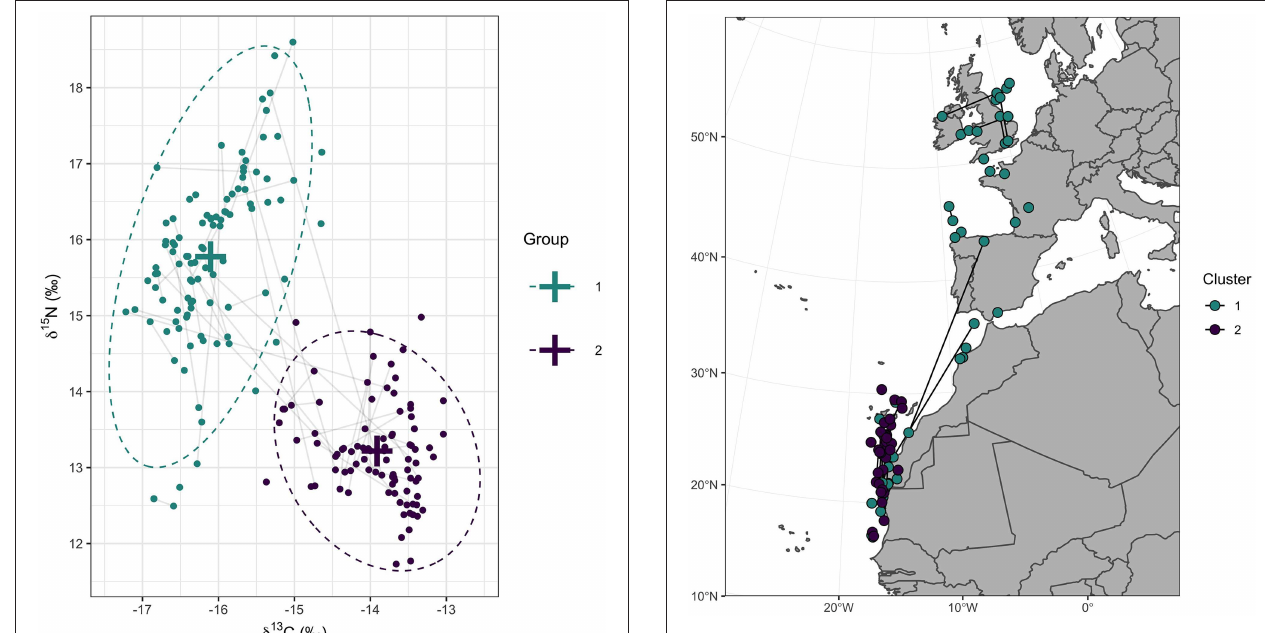
FIGURE 4 | Centroid December locations of 56 northern gannets colored by assignment to one of two isotopic clusters based on a multivariate mixture model of primary feather δ 13 C and δ 15 N. Dark lines connect individuals ( n = 22) sampled in two consecutive